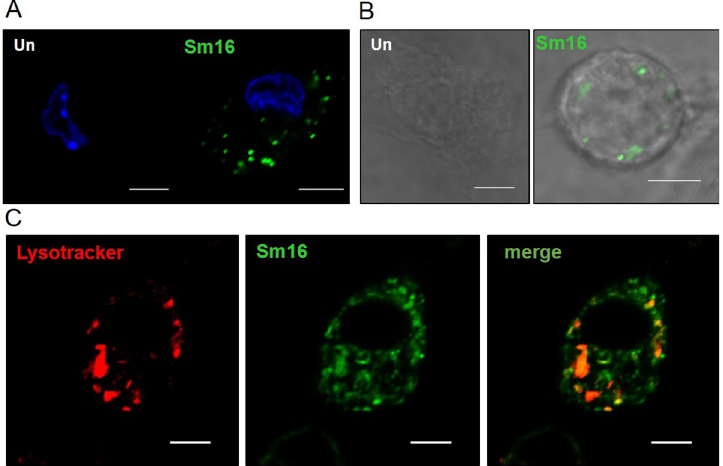
Fig 5. Sm16 is internalised by macrophages. ( A ) BMDMs (7 x 10 6 ) were untreated (Un) or incubated with 10 μ g/ml Alexa Fluor 488-conjugated recombinant Sm16 (Sm16) in media for 30 min at 37˚C, 5% CO 2 , prior to fixation with 4% PFA. Samples were also stained with DAPI for identification of the cell nucleus. ( B ) BMDMs (7 x 10 6 ) were untreated (Un) or incubated with 10 μ g/ml Alexa Fluor 488-conjugated synthetic Sm16 (34–117) (Sm16) in media for 30 min at 37˚C, 5% CO 2 , prior to fixation with 4% PFA. ( C ) BMDMs (7x10 6 ) were incubated with Alexa 488-conjugated recombinant Sm16 (10 μ g/mL) in media with 60 nM LysoTracker for 30 min at 37˚C, 5% CO2. Visual identification of fluorescence in the respective channels was used to construct the panels; Sm16 staining shown in green, DAPI staining in blue and LysoTracker staining shown in red. Co-localization identification was confirmed by automated analysis using the NIS software. Scale bar: 5 μ